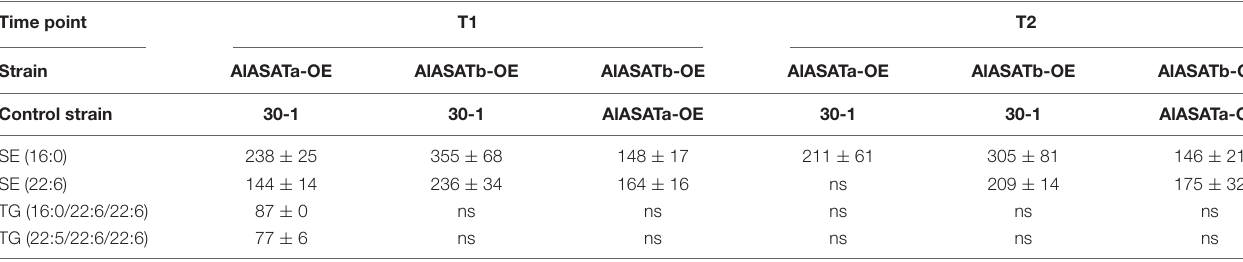
TABLE 2 | The relative amounts (%) of lipid species in OE strains. Time point T1 T2 Strain AlASATa-OE AlASATb-OE AlASATb-OE AlASATa-OE AlASATb-OE AlASATb-OE Control strain 30-1 30-1 AlASATa-OE 30-1 30-1 AlASATa-OE